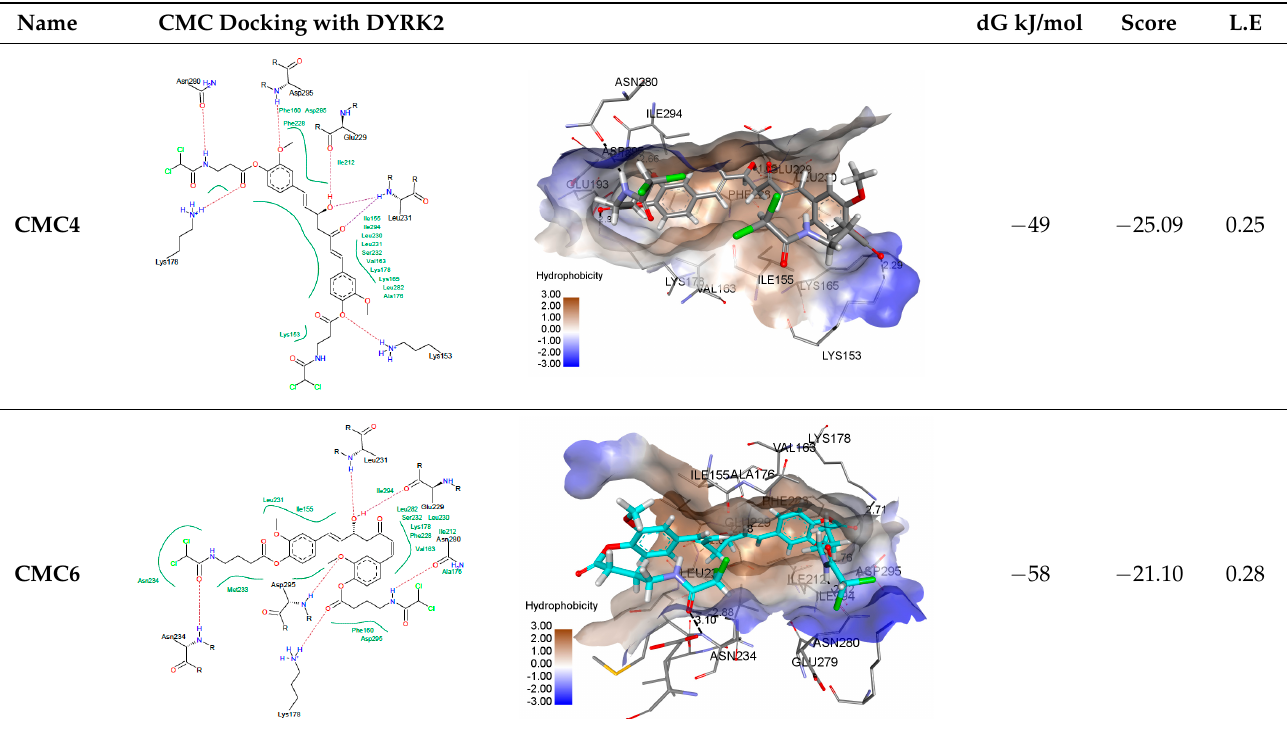
Table 3. Predicted ADME properties of CMC compounds.